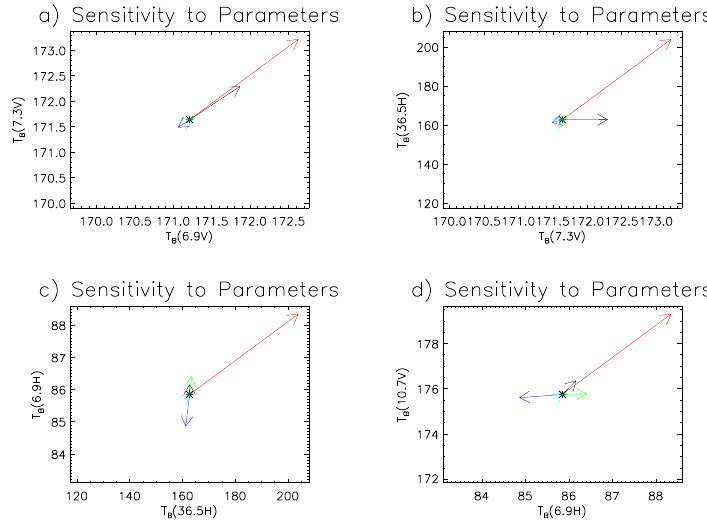
Figure 10. Sensitivity diagrams for an example atmospheric profile with low total cloud liquid water (SST = 296 K, TCWV = 36.2 kg m − 2 , u = 4.8 m s − 1 , v = 8.3 m s − 1 , TCLW = 0.017 kg m − 2 ). Each arrow indicates, for two channels, the product of the brightness temperature sensitivity to a variable and the a priori uncertainty in that variable i.e. each arrow shows ∂ y ∂ x σ i for the channels in y indicated on the figure axes. This is a measure of the magnitude of the response of the observations to the range of uncertainty in each retrieved variable. The variables are SST (black), ln(TCWV) (red), u (green), v (blue) and ln(TCLW) (cyan). The pairs of channels in each diagram are ordered (a)–(d) in accordance with the information content analysis for a five-variable retrieval vector in table 1.